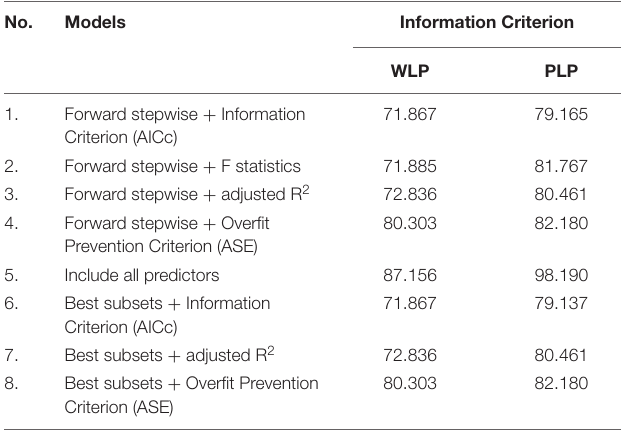
TABLE 3 | Information criterion of different models in ALM.